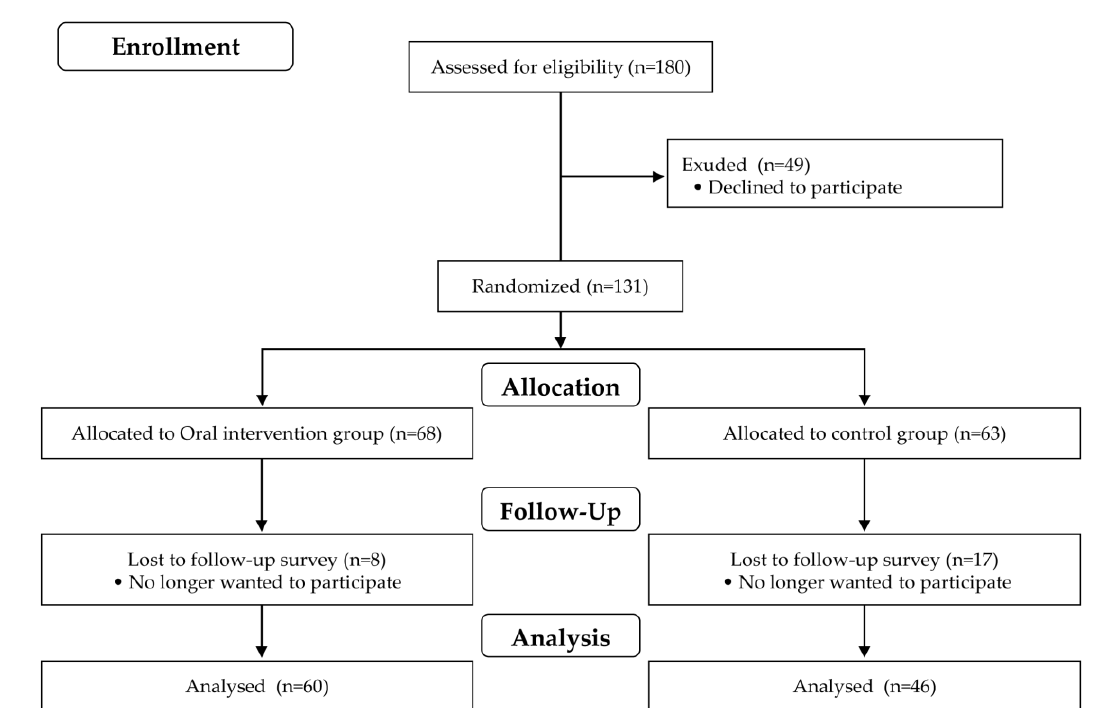
Figure 2. Flowchart of the study.